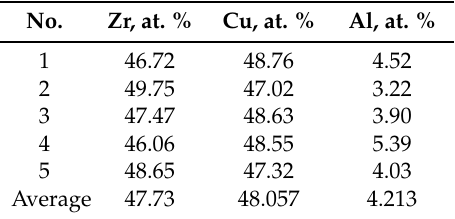
Figure 3. SEM and energy dispersive spectroscopy (EDS) analysis of Cu 48 Zr 48 Al 4 amorphous microwire. ( a ) Morphology of microwire. ( b – d ) Elements distributions of Zr, Cu, and Al, respectively. ( e ) Energy spectrum of microwire. Table 1. Composition analysis by EDS. Table 1. Composition analysis by EDS.